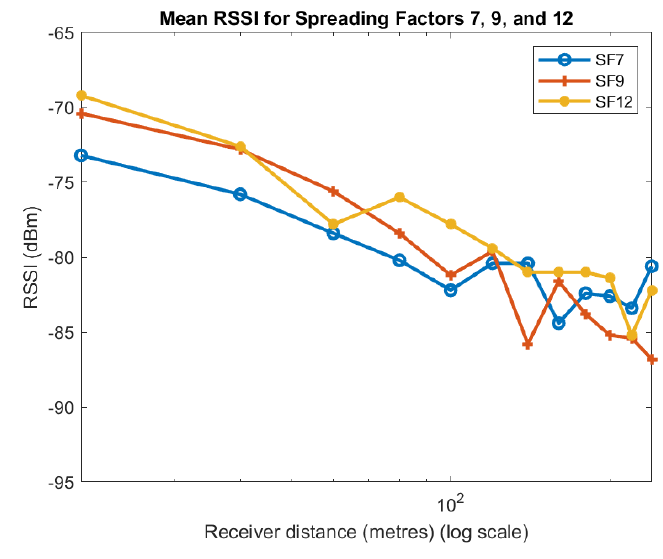
Figure 7. Effect of SF on RSSI.